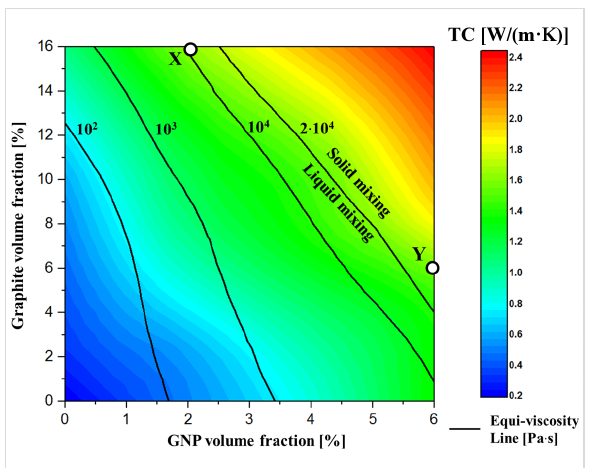
Figure 5: Phase diagram showing thermal conductivity (color map) and viscosity (black equi-viscosity lines) produced by interpolation of the experimental data in Figure 4a and 4b. The compositions of the samples used for functional tests (X and Y) are marked with